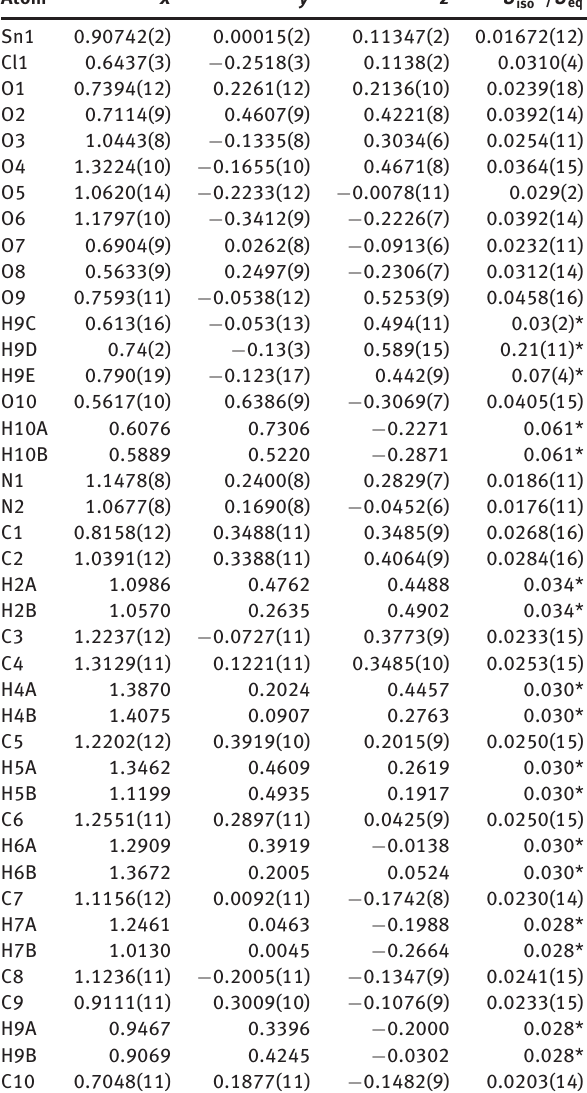
Table 2: Fractional atomic coordinates and isotropic or equivalent isotropic displacement parameters (Å 2